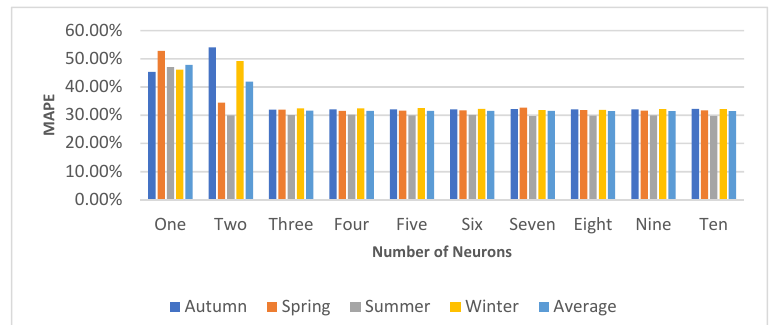
Figure 4. The comparative MAPE of different numbers of ANN neurons.